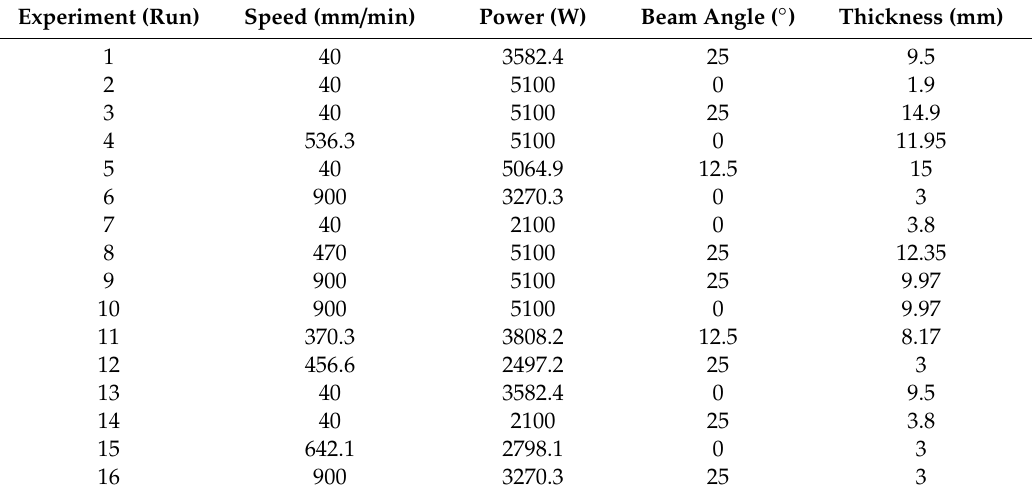
Table 2. Design matrix containing the 16 runs.